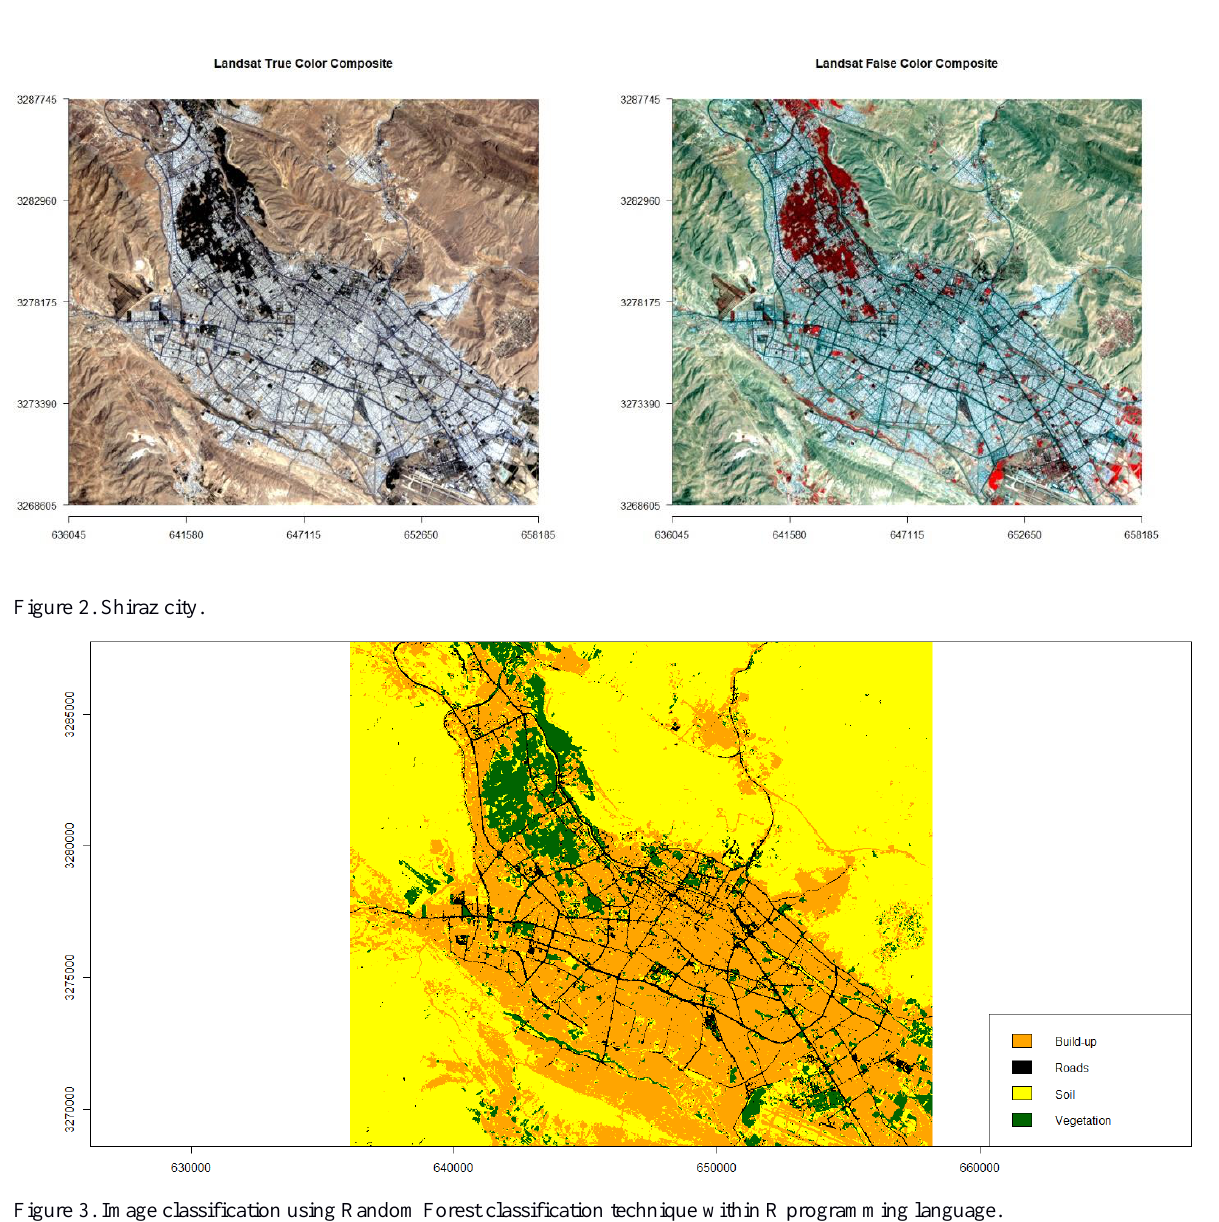
Figure 3. Image classification using Random Forest classification technique within R programming